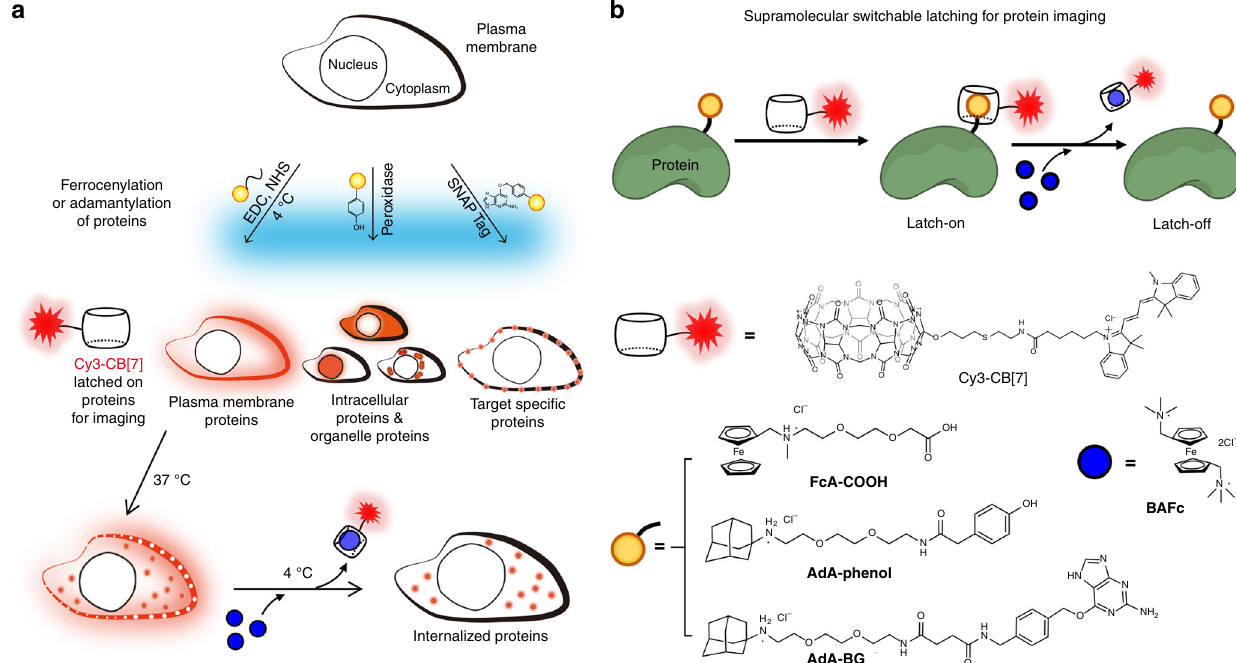
Fig. 1 Schematic illustration of protein imaging. a Universal and selective imaging of cellular proteins using a switchable supramolecular latching system based on the ultrastable host – guest interactions between Cy3-CB[7] and AdA (or FcA); b CB[7]-based ultrastable binding pairs used in this